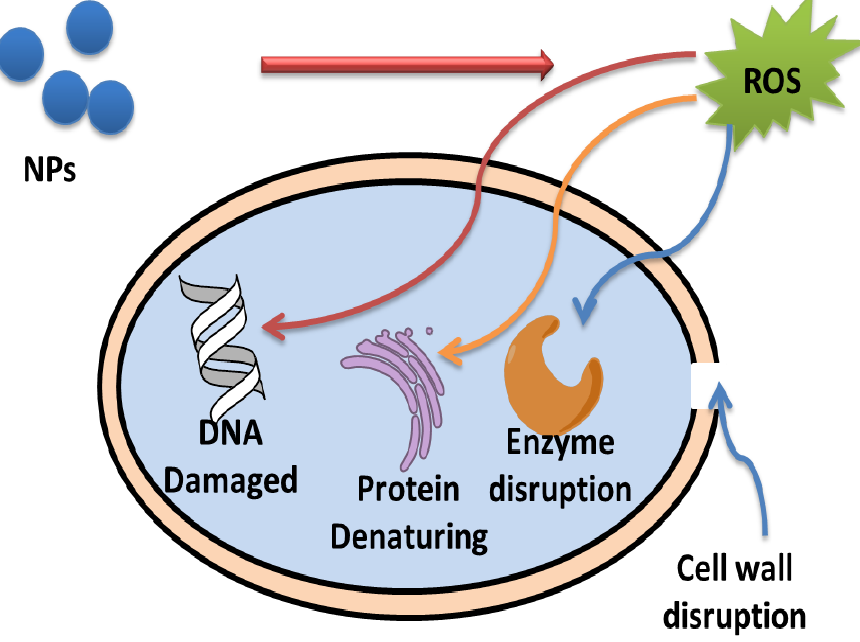
Figure 6. The antibacterial mechanism of iron oxide NPs.